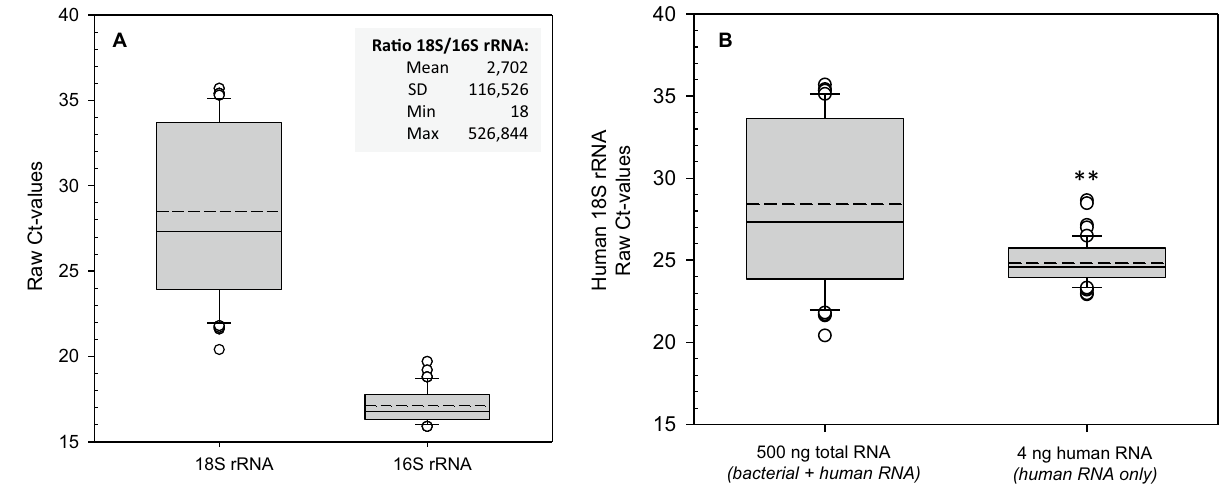
500 ng total RNA 4 ng human RNA (bacterial + human RNA) (human RNA only) Figure 3. The box plots in ( A ) display the human 18S rRNA and bacterial 16S rRNA raw Ct values (threshold cycles) for all whole saliva samples (n = 91). Dashed lines represent the mean, solid lines the median and dots the outliers. The input amount for cDNA synthesis for each sample was 0.5 µg. The inserted table shows the calculated ratio between raw Ct values of human 18S rRNA and bacterial 16S rRNA and provides descriptive statistics: mean, minimum [min], maximum [max], standard deviation [stdev] and standard error of the mean [sem]. The box plots in ( B ) represent the human 18S rRNA raw Ct-values before and after adjustments accounting for input differences from left to right. The left part shows Ct values from 1st qRT-PCR performed using cDNA with an input of 500 ng total RNA (bacterial and human RNA) and the right boxplot the corresponding results when taking 4 ng of human RNA (calculated via the 18S/16S-ratio together with total RNA concentration values measured). Asterisks (**) refer to a P value < 0.001 using 500 ng total RNA measurements as